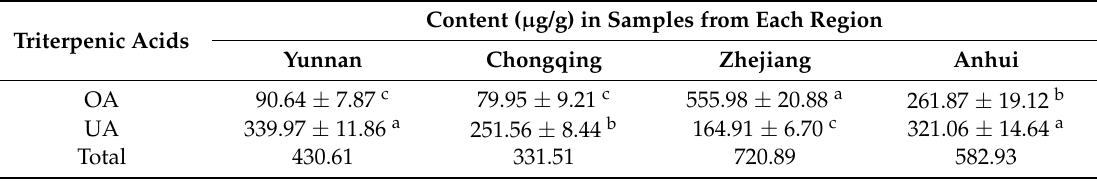
Table 4. OA and UA contents in the dried fruits of C. speciosa from four production